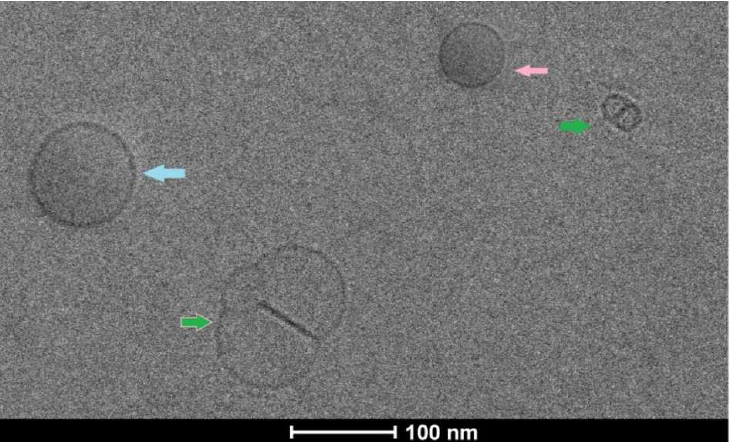
Figure 3. Cryo-TEM images: pink color and sky blue color arrow indicate small unilamellar vesicle (near about 50 nm in diameter) and unilamellar vesicle (near about 100 nm in diameter), respectively. Green color arrow represents two unilamellar vesicles fused with each other. Table 1. Weight % and atomic % of elements in various